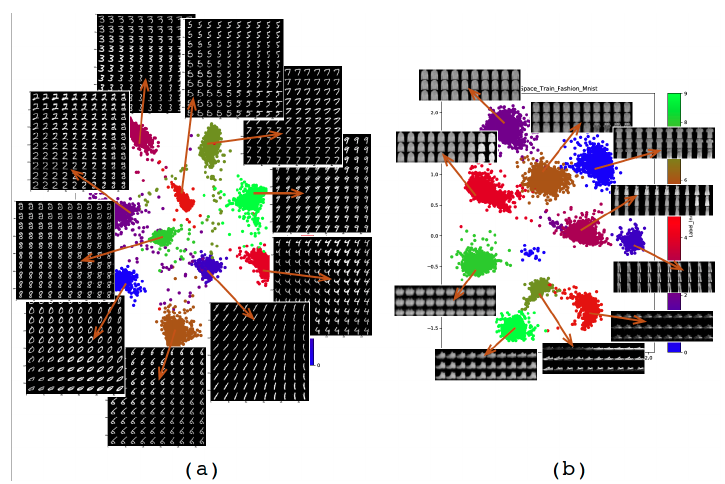
Figure 8. Images generated from the latent space for the ( a ) Mnist and ( b ) the Fashion Mnist.